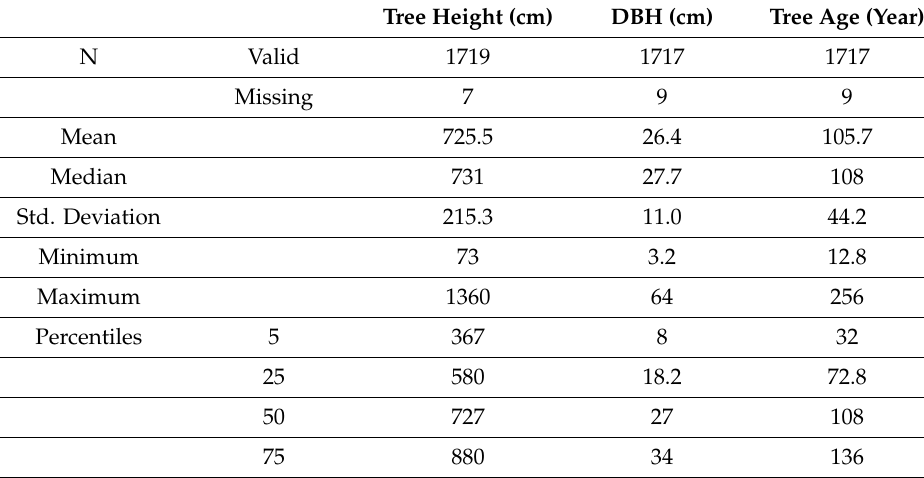
Table 1. Dimensions of Fukugi trees at the survey